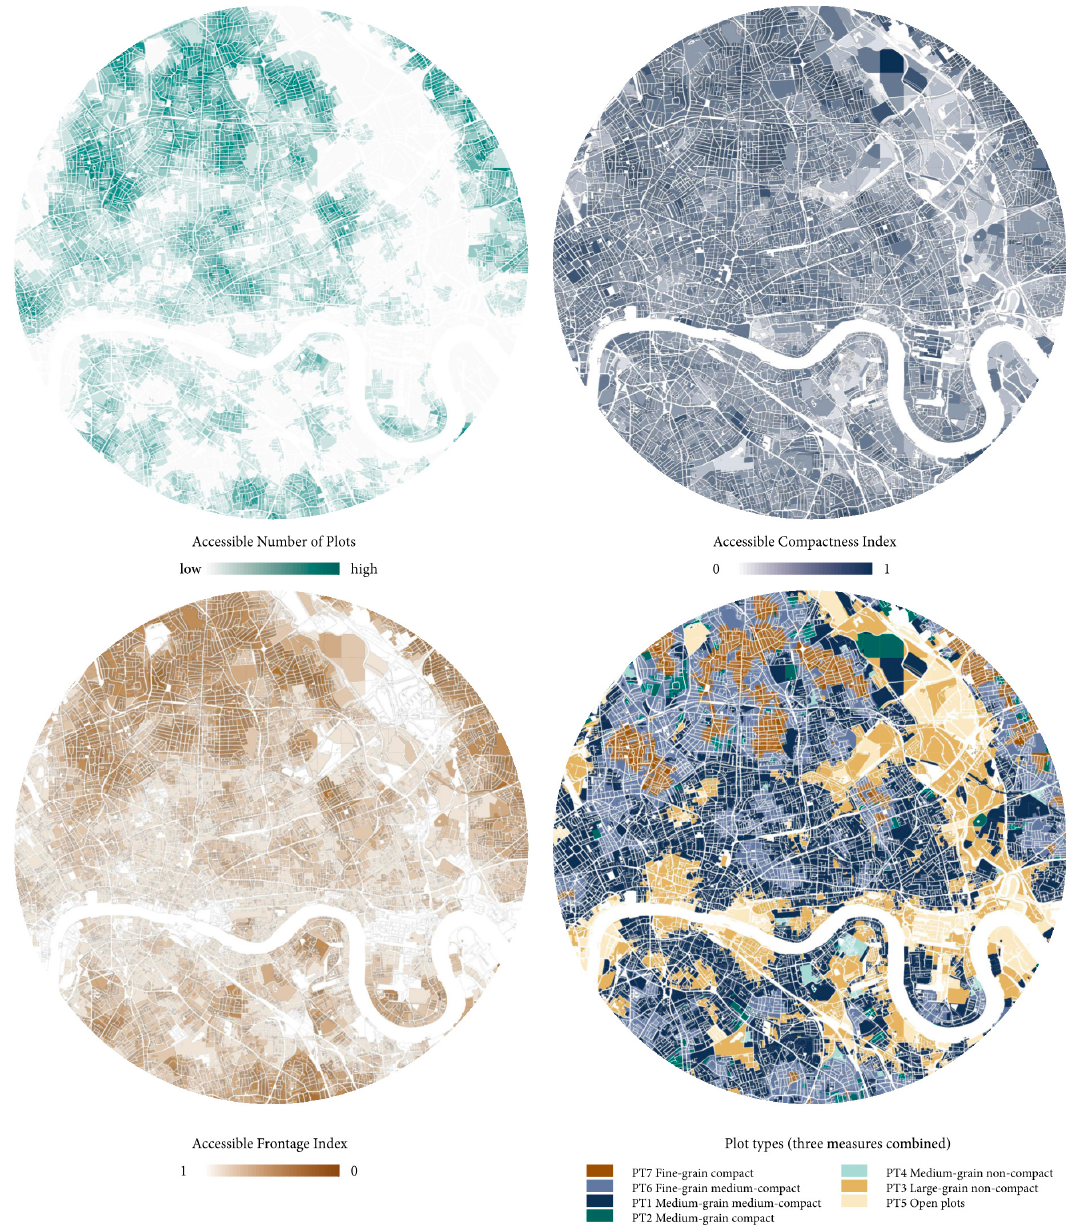
Figure A2. London. Overview of three plot measures (accessible number of plots, accessible compactness index, accessible frontage index) and seven plot types that combine these three measures.